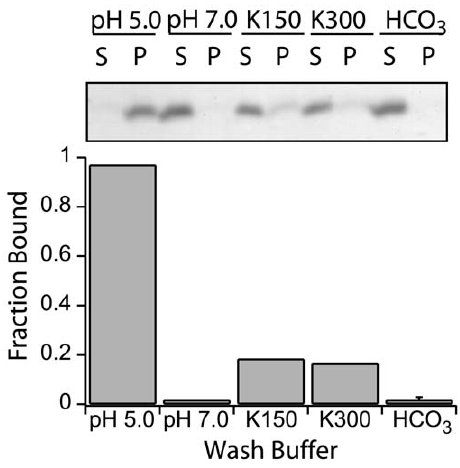
Figure 4. Fis1 D TM membrane interaction is reversible. A vesicle sedimentation assay was used to measure reversibility of Fis1 D TM bound to lipid vesicles. 5 m M Fis1 D TM was incubated with 100 m M lipids (1:20 protein:lipid) at pH 5.0, centrifuged, resuspended in the indicated buffers: a pH 5.0 buffer control (pH 5.0), buffer at pH 7.0 (pH 7.0), buffer at pH 5.0 with an additional 150 mM KCl (K150), buffer pH 5.0 with an additional 300 mM KCl (K300), or 200 mM Na 2 CO 3 pH 11.7 (HCO 3 ). Resuspended vesicles were then analyzed for fraction bound as shown previously. Panel depicted as in Figure 1.